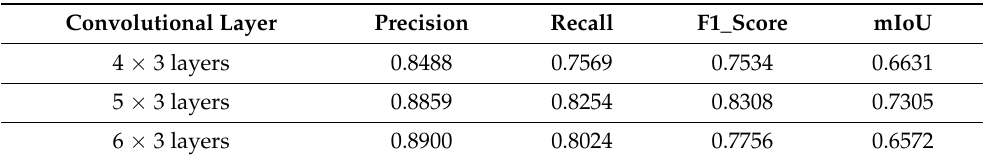
Table 3. Quantitative evaluation of topographic CNN with the different number of convolutional layers.